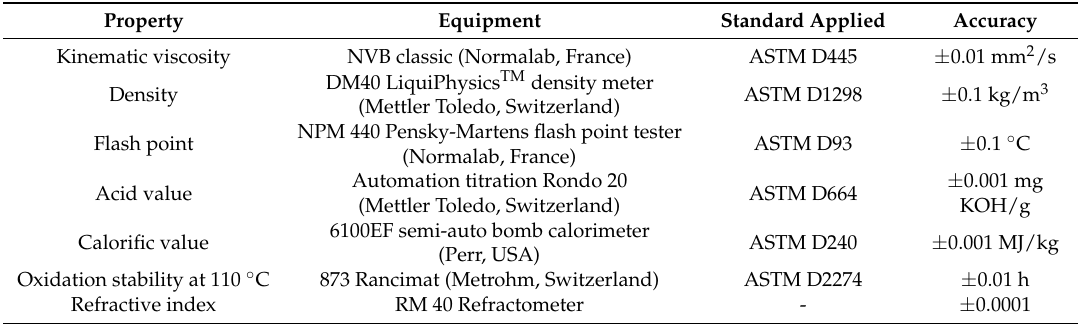
Table 1. Equipment used for measuring properties of papaya seed oil (PSO) and related products in this